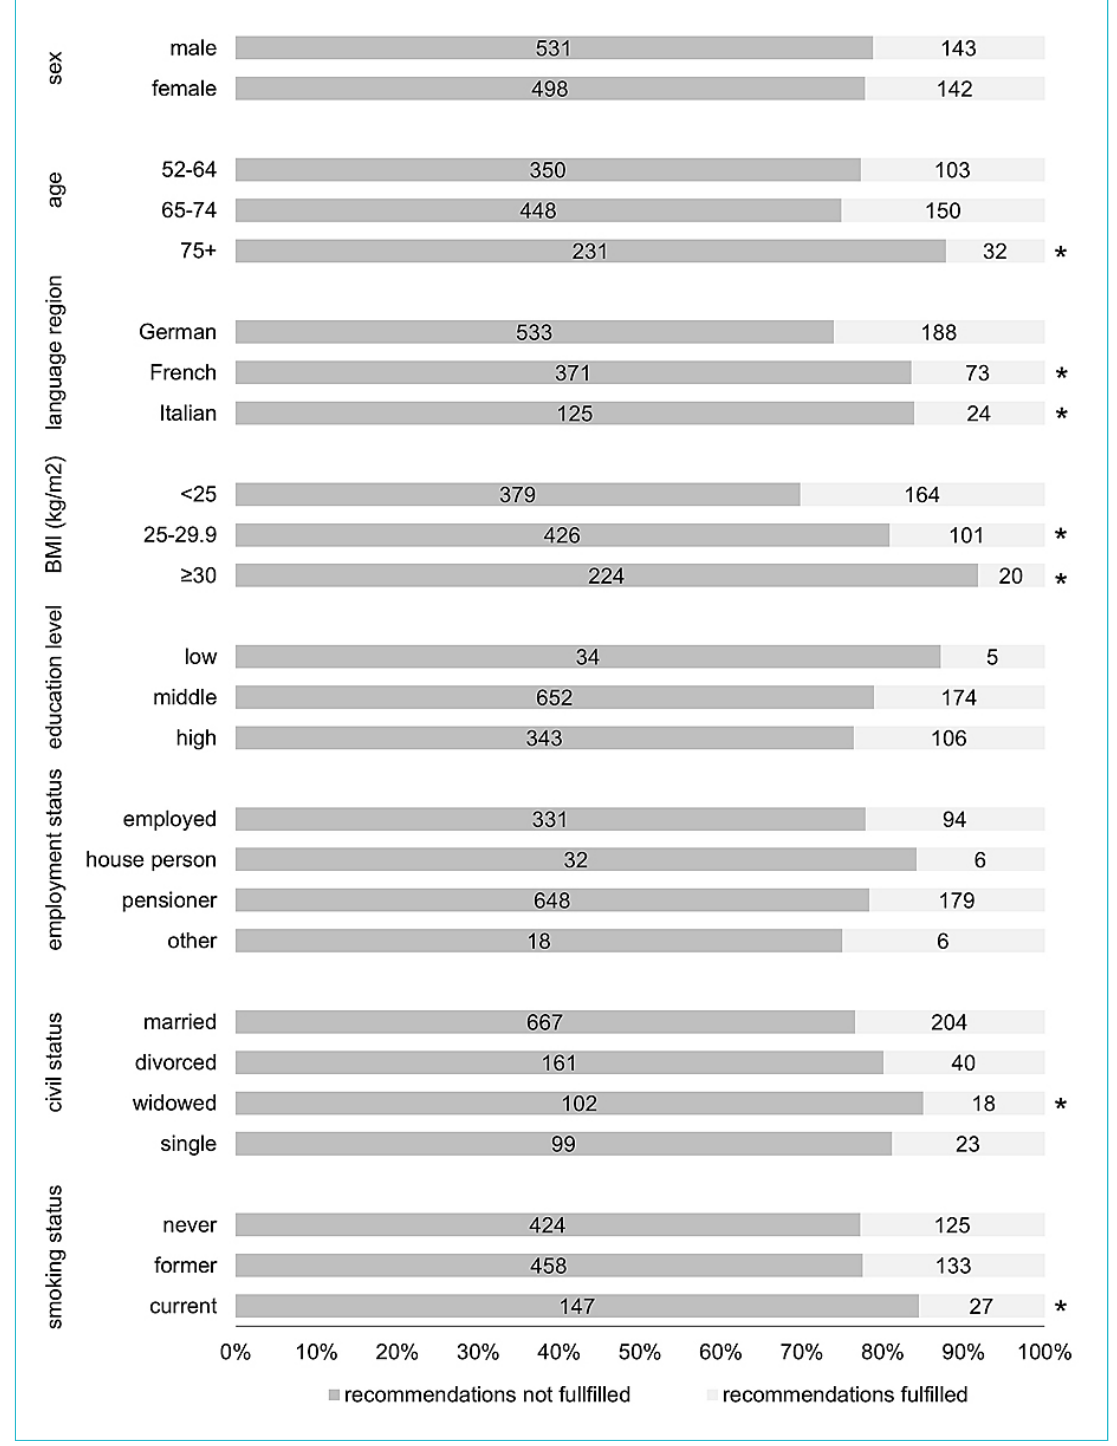
Figure 3: Number (boxes) and percent (x-axis) of participants meeting the Swiss recommendations for Physical Activity (150 minutes in mod- erate physical activity or 75 minutes in vigorous physical activity) according to participant characteristics using logistic regression. An asterisk * indicates a statistically significant difference between the groups at p-value